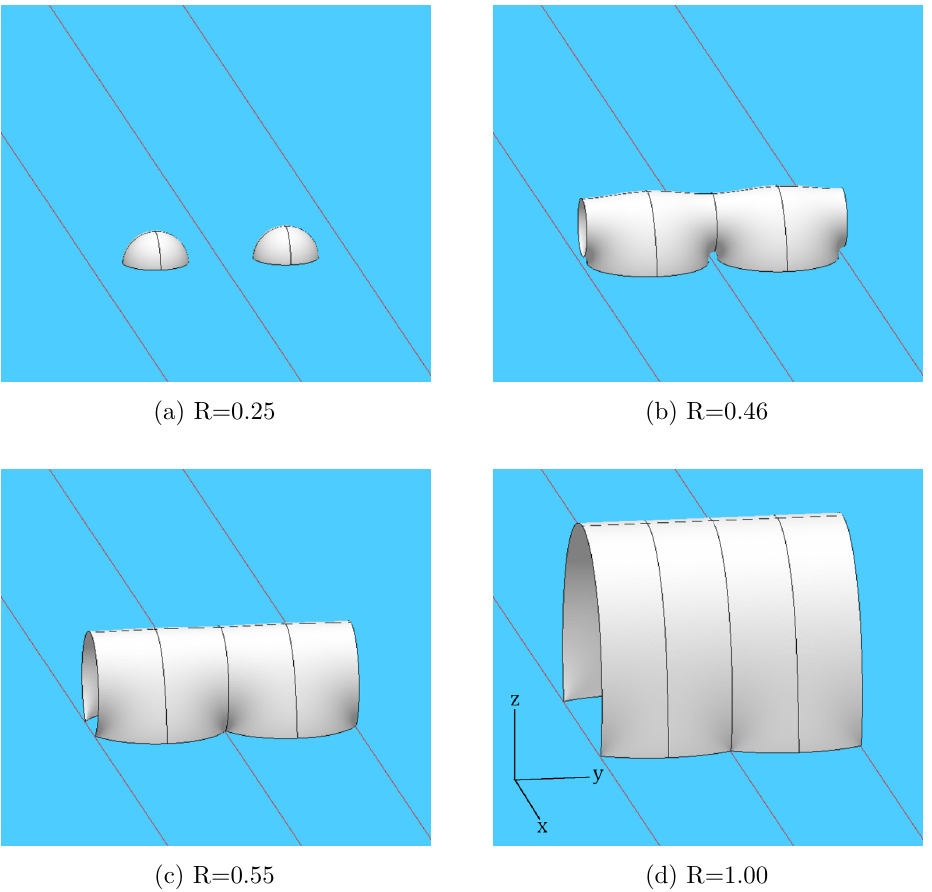
Figure 4. Example minimal surfaces for the process in figure 3. The CFT has spatial geometry R × S 1 and the bulk is taken as AdS 4 with periodic identification. The red lines, at unit separation in the y direction, are identified. For small regions (a), the minimal surface has the shape of a spherical cap. As the region approaches the size of the compact space, a topology transition occurs and “bridges” form between neighboring domains (panel (b)). In (c), the diameter of the region surpasses one and the EE picks up corner contributions. As the region continues to grow, these contributions decrease